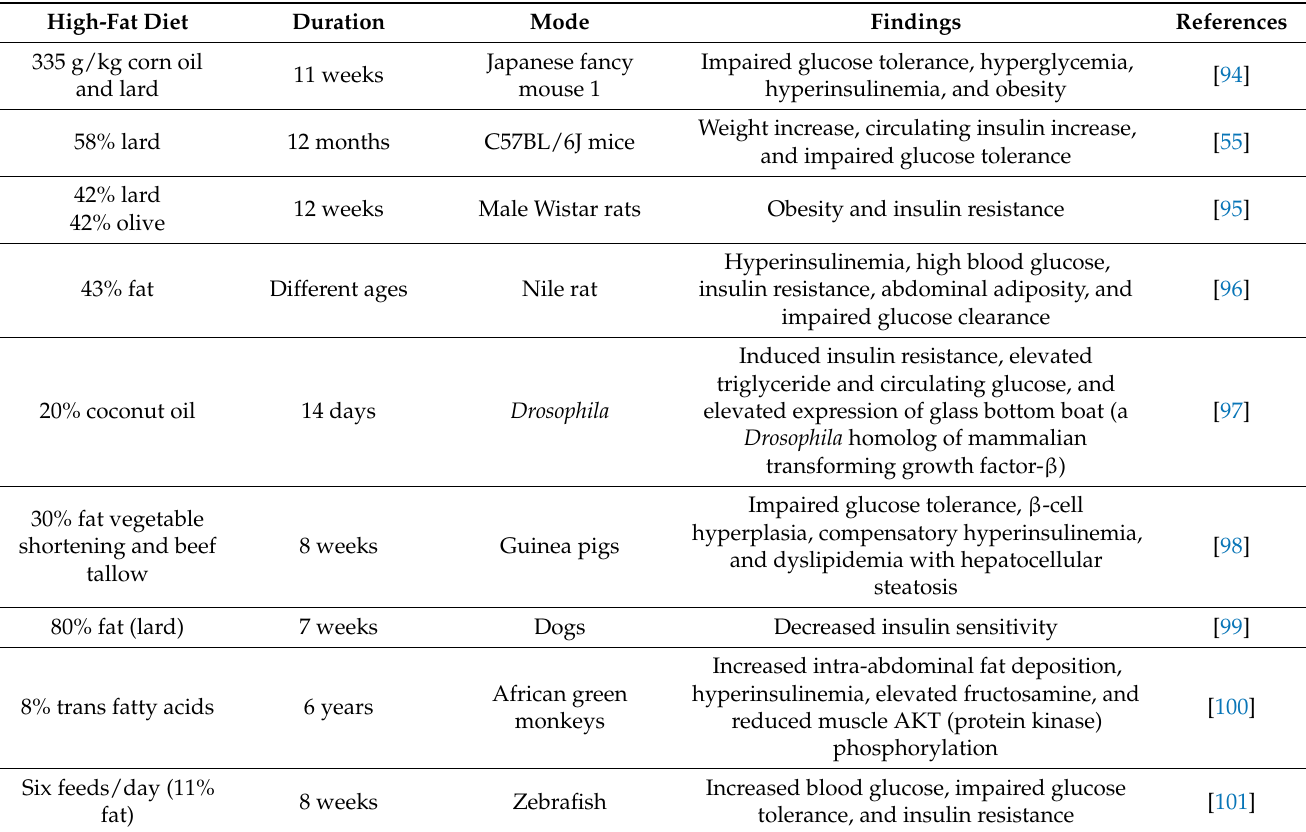
Table 2. Animal model of high-fat-diet-induced diabetes